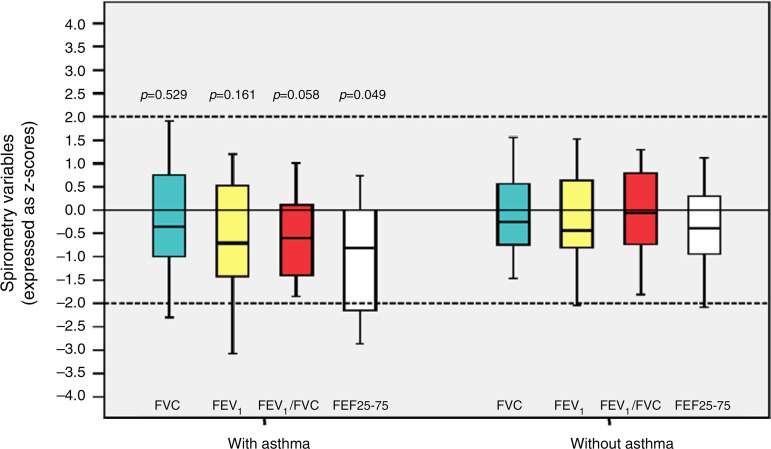
Distribution of z-scores in relation to asthma in children and adolescents who were very low birth weight (VLBW) newborns regarding spirometry variables. FVC, forced vital capacity; FEV1, forced expiratory volume in one second; FEV1/FVC, ratio between FEV1 and FVC; FEF 25-75%, mean expiratory flow between 25% and 75% of FVC; p, p-value. Medians are present as horizontal lines that divide the rectangles, which contain 50% of values. The bars extend to the maximum and minimum values. Two-tailed Student's t-test.